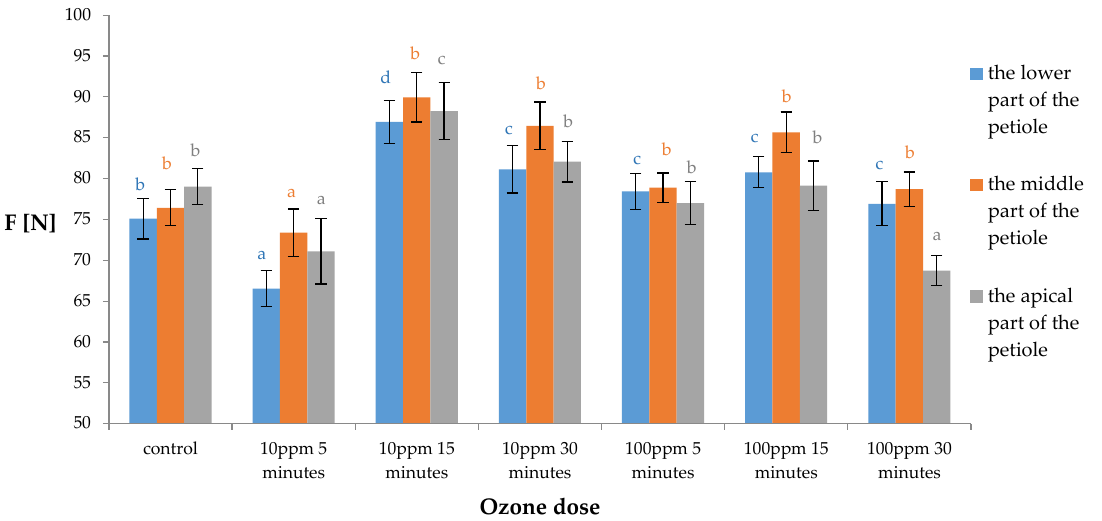
Figure 2. Mean values of the force needed to puncture the skin with ϕ = 6 mm indenter, on the Figure 2. Mean val ues of the force needed to puncture the skin with φ = 6 mm indenter, on the backside of rhapontic rhubarb petioles. Di ff erences in the results between the punching force values for backside of rhapontic rhubarb petioles. Differences in the results between the punching force individual variants are marked with di ff erent small letters, p < values for individual variants are marked with different small letters, p < 0.05.